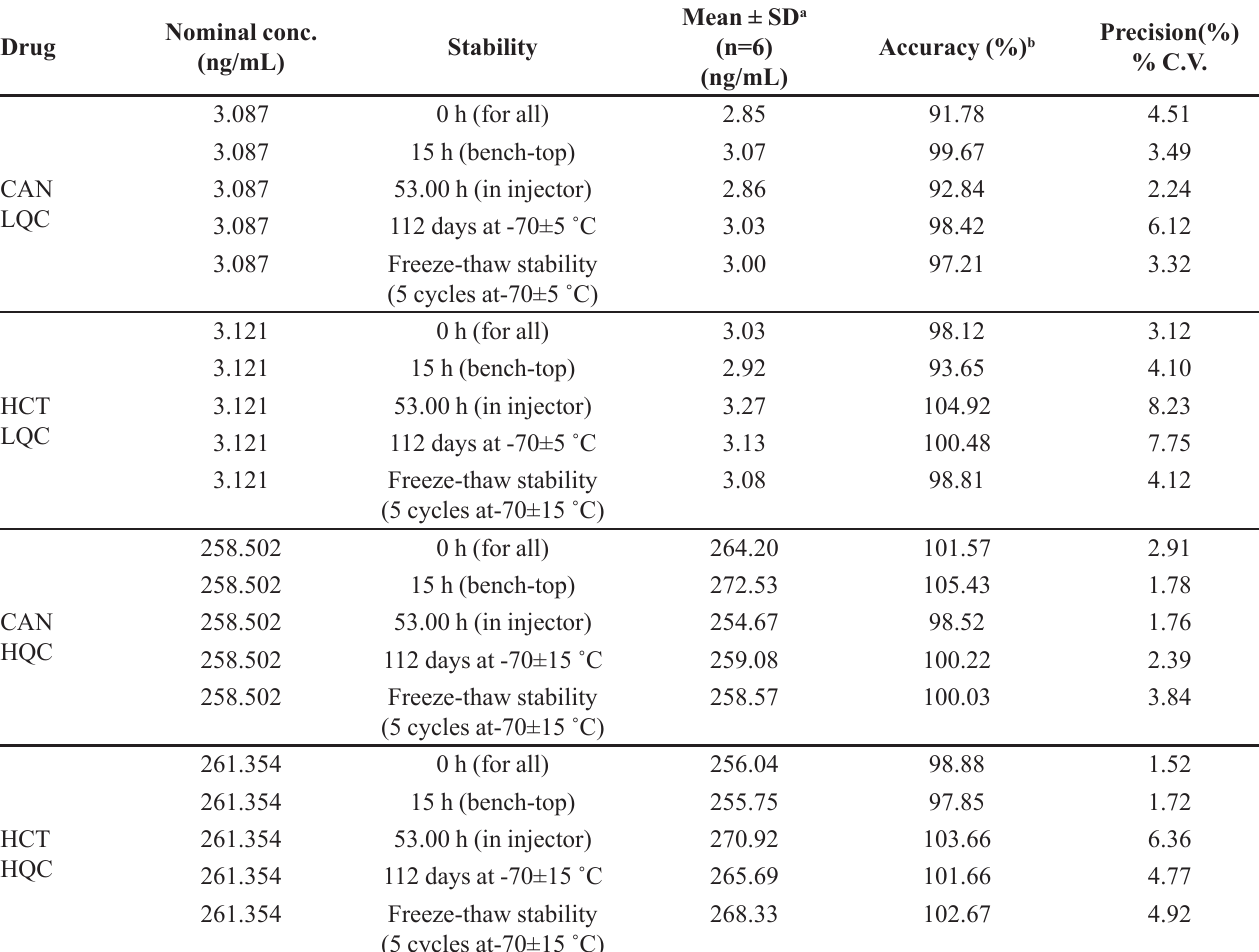
TABLE V - Stability data of CAN and HCT quality controls in human plasma Nominal conc. Drug (ng/mL)